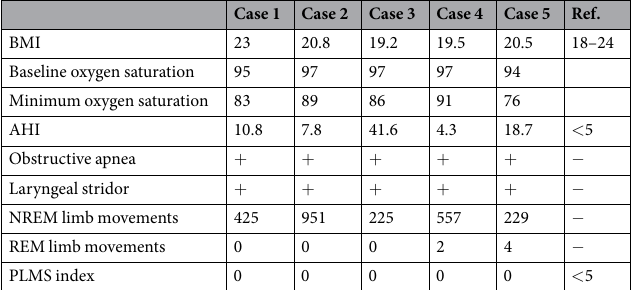
Table 3. Sleep-related respiratory disturbance and leg-movement indices of the five FFI patients. AHI: apnea/ hypopnea index; PLMS: periodic leg movement in sleep; + : symptom/sign observed; − : symptom/sign not observed.